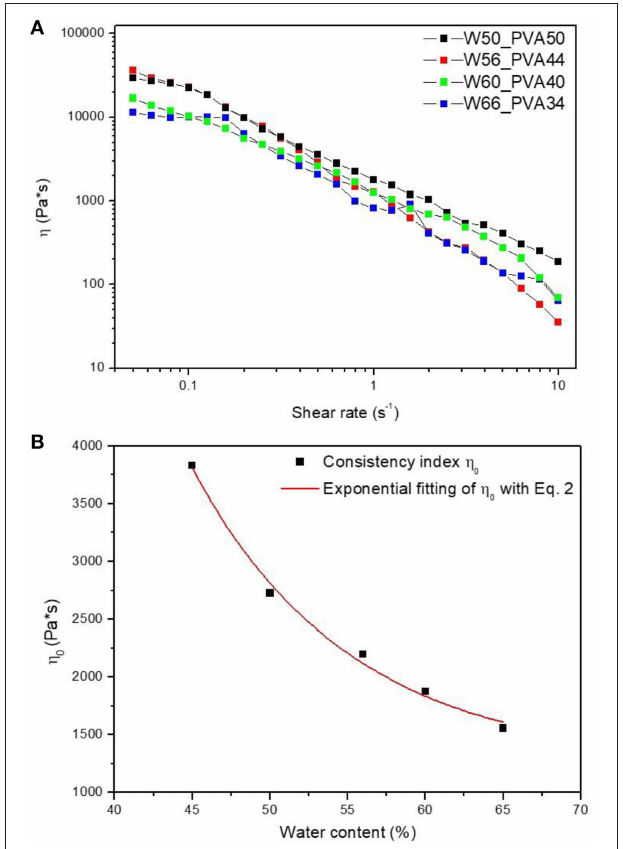
FIGURE 1 | (A) Steady rate sweep tests on PVA samples with different water contents and (B) consistency index η 0 as a function of water